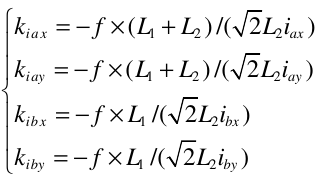
Figure 15. Schematic of current stiffness